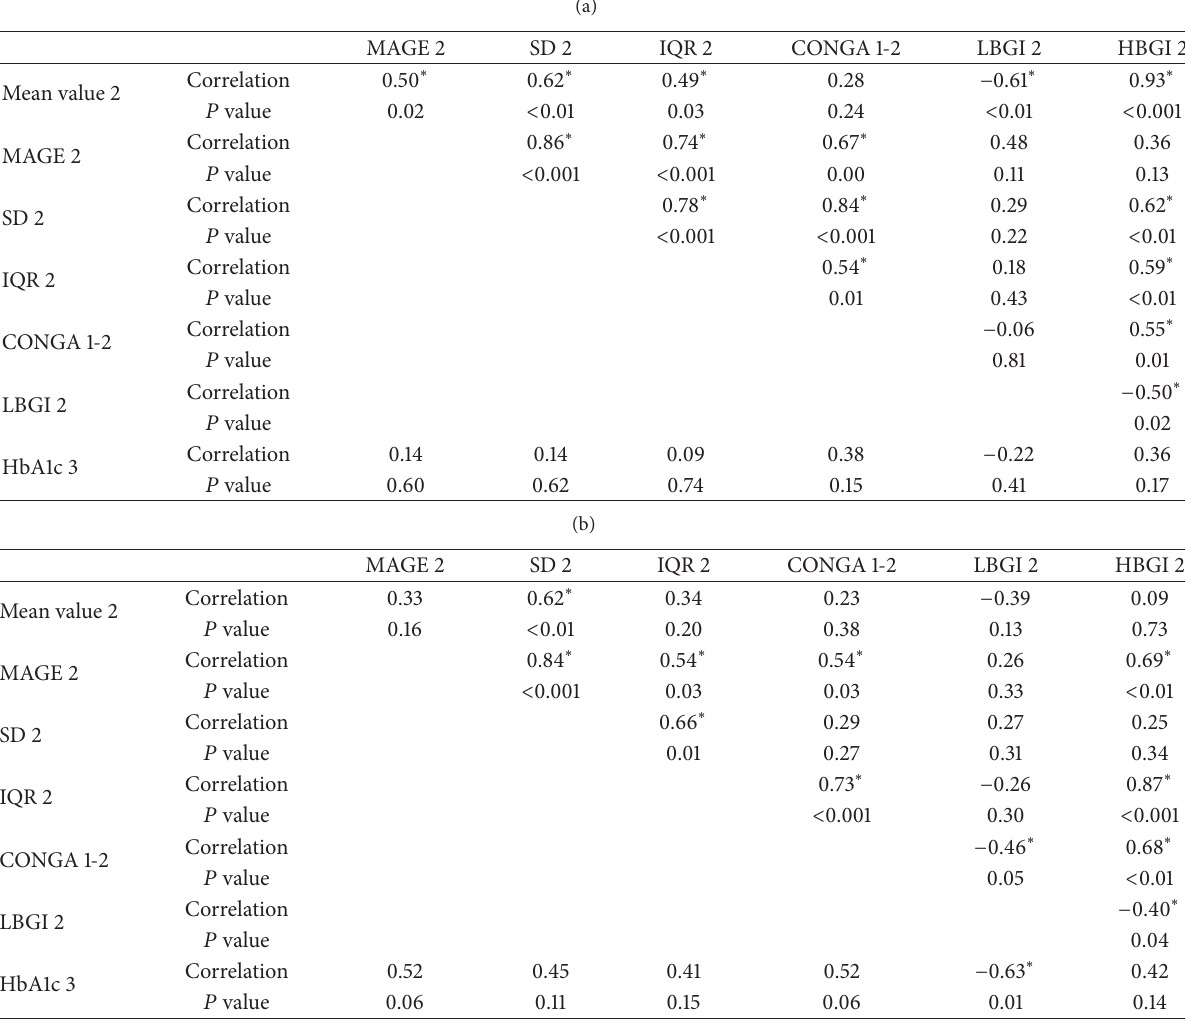
Table 1: Correlations between indicators of glucose variability and mean glucose value (mean value) obtained in the 2nd trimester and with HbA1c obtained in the 3rd trimester of pregnancy. Pearson’s analysis was performed on type 1 diabetes (Table 1(a)) and GDM patients (Table